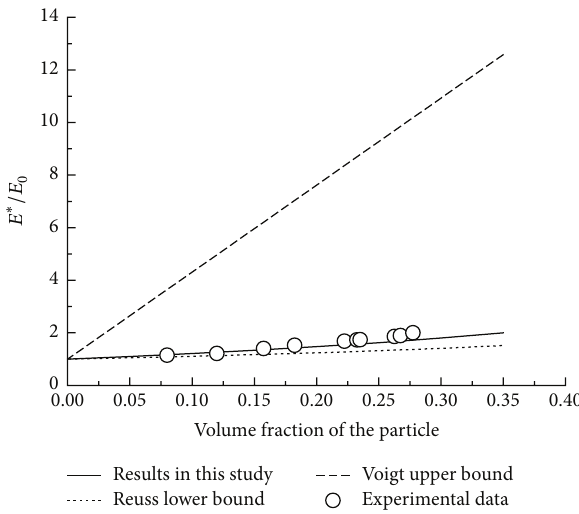
Figure 10: The comparison among the results obtained with the proposed micromechanical model, those obtained experimentally [49], those estimated by the Reuss lower bound,and the Voigt upper bound for the effective Young modulus of the nonporous composite.